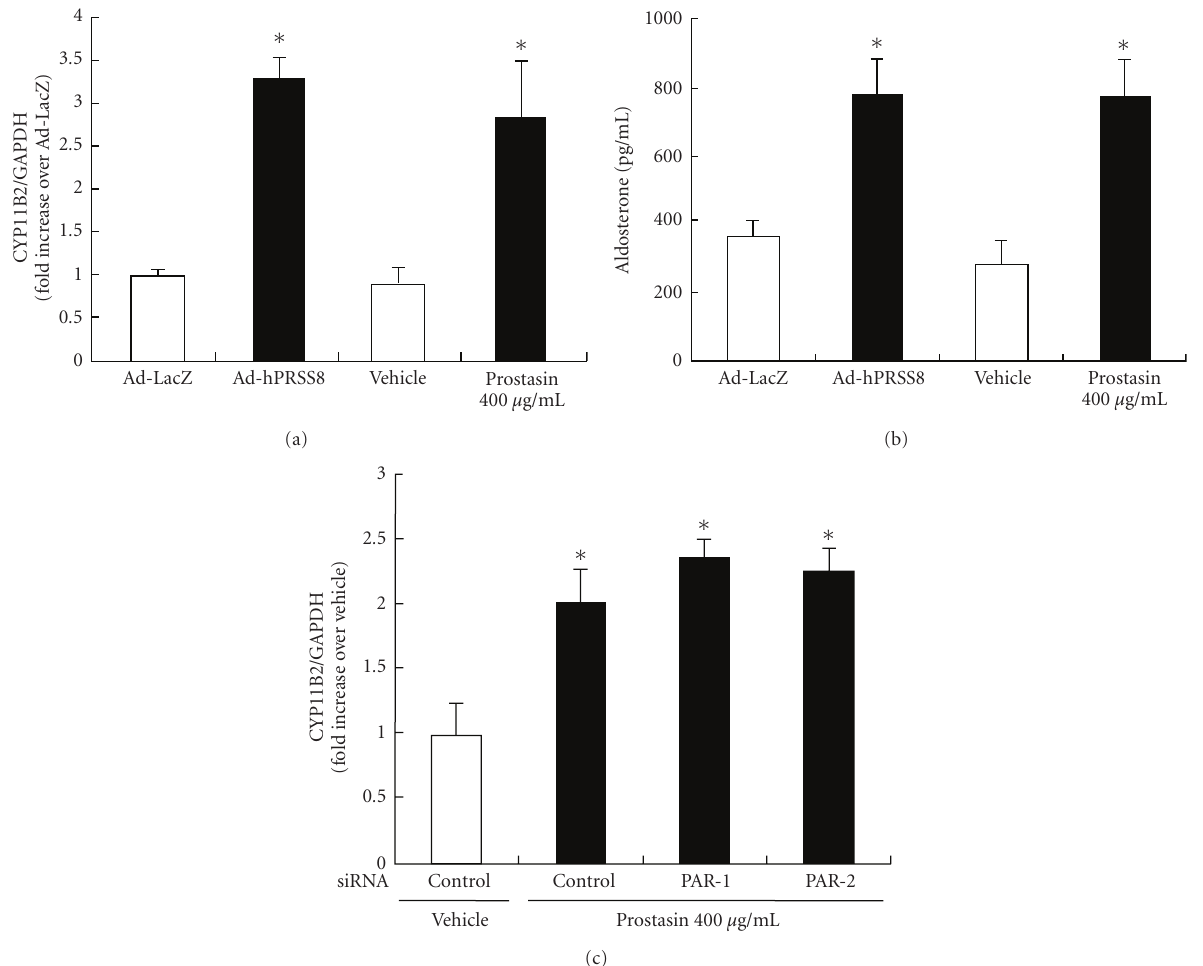
Figure 2: E ff ect of adenovirus-mediated overexpression of prostasin on CYP11B2 expression (a) and aldosterone production (b) in H295R cells. Cells were infected with 6 × 10 5 pfu of control virus (Ad-LacZ) or adenovirus carrying human prostasin (Ad-hPRSS8) for 1 hour. Forty eight hours after infection, total RNA was isolated for the real time PCR and the medium was collected for the aldosterone measurement. (c) E ff ect of PAR-1 or PAR-2 knock down on prostasin-induced CYP11B2 expression in H295R cells. Cells were transfected with siRNA for either PAR-1 or PAR-2 for 48 hours and then treated with prostasin for another 24 hours. mRNA expression of CYP11B2 was determined by the real time PCR. Values are means ± SD ( n = 6). ∗ P < . 001 versus Ad-LacZ (a), (b), or vehicle